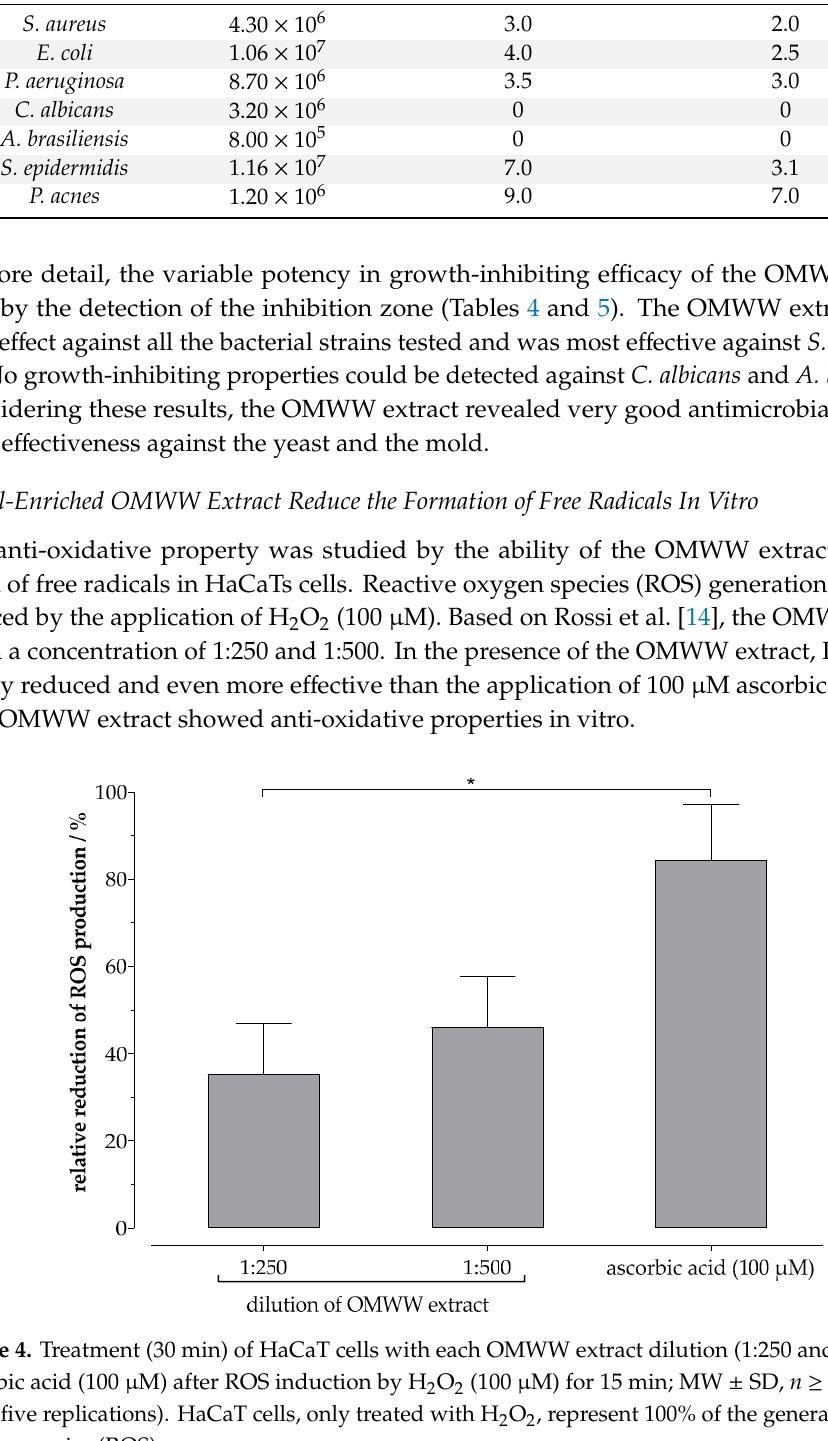
Table 5. Quantification of the inhibition zone formed, depending on the microorganism and its inoculation density for the punch hole method and paper disc method.